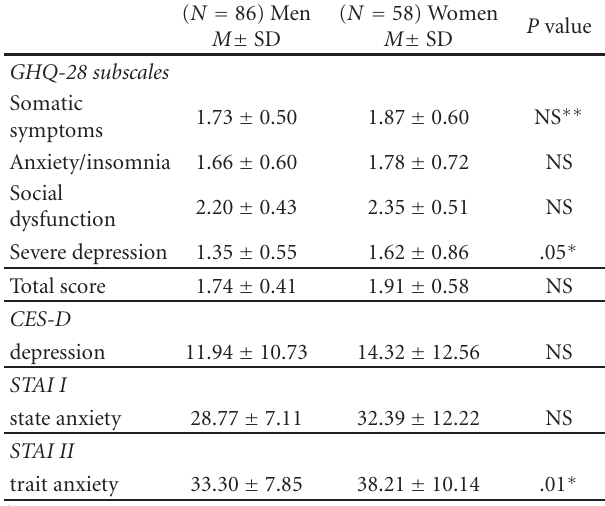
Table 3: Mean scores ± SD of GHQ-28 health subscales and depression. Independent samples t -test demonstrating di ff erences between the two categories of age.